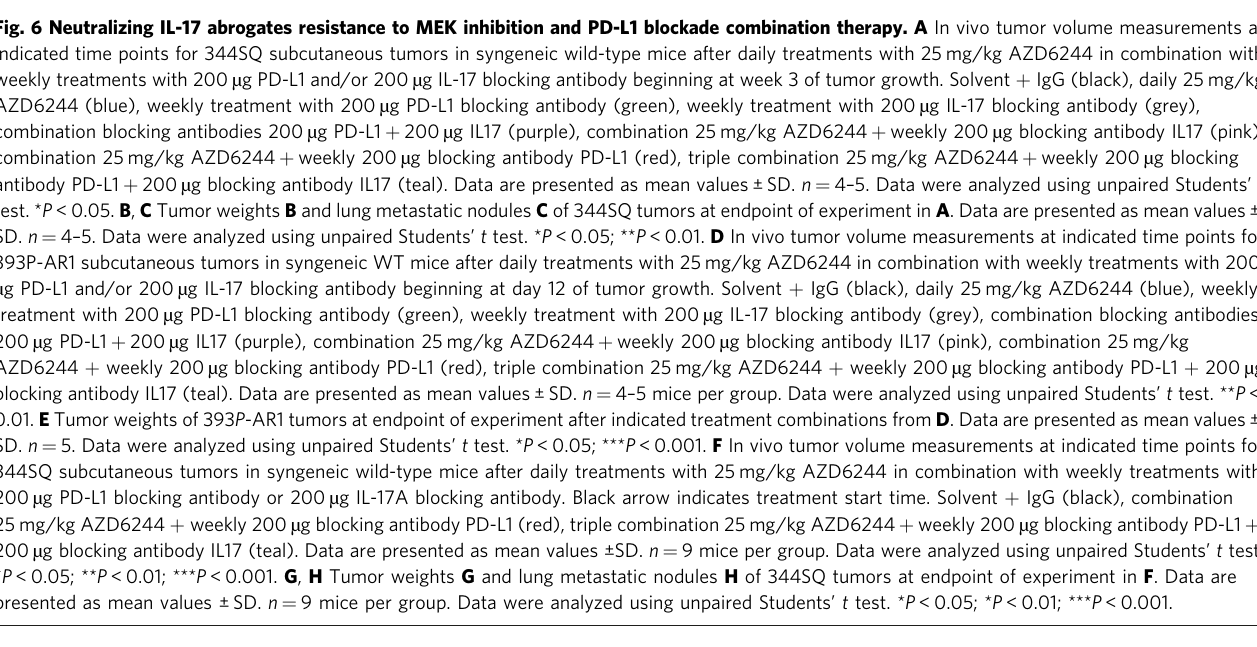
Fig. 6 Neutralizing IL-17 abrogates resistance to MEK inhibition and PD-L1 blockade combination therapy. A In vivo tumor volume measurements at indicated time points for 344SQ subcutaneous tumors in syngeneic wild-type mice after daily treatments with 25 mg/kg AZD6244 in combination with weekly treatments with 200 µ g PD-L1 and/or 200 µ g IL-17 blocking antibody beginning at week 3 of tumor growth. Solvent + IgG (black), daily 25 mg/kg AZD6244 (blue), weekly treatment with 200 µ g PD-L1 blocking antibody (green), weekly treatment with 200 µ g IL-17 blocking antibody (grey), combination blocking antibodies 200 µ g PD-L1 + 200 µ g IL17 (purple), combination 25 mg/kg AZD6244 + weekly 200 µ g blocking antibody IL17 (pink), combination 25 mg/kg AZD6244 + weekly 200 µ g blocking antibody PD-L1 (red), triple combination 25 mg/kg AZD6244 + weekly 200 µ g blocking antibody PD-L1 + 200 µ g blocking antibody IL17 (teal). Data are presented as mean values ± SD. n = 4 – 5. Data were analyzed using unpaired Students ’ t test. * P < 0.05. B , C Tumor weights B and lung metastatic nodules C of 344SQ tumors at endpoint of experiment in A . Data are presented as mean values ± SD. n = 4 – 5. Data were analyzed using unpaired Students ’ t test. * P < 0.05; ** P < 0.01. D In vivo tumor volume measurements at indicated time points for 393P-AR1 subcutaneous tumors in syngeneic WT mice after daily treatments with 25 mg/kg AZD6244 in combination with weekly treatments with 200